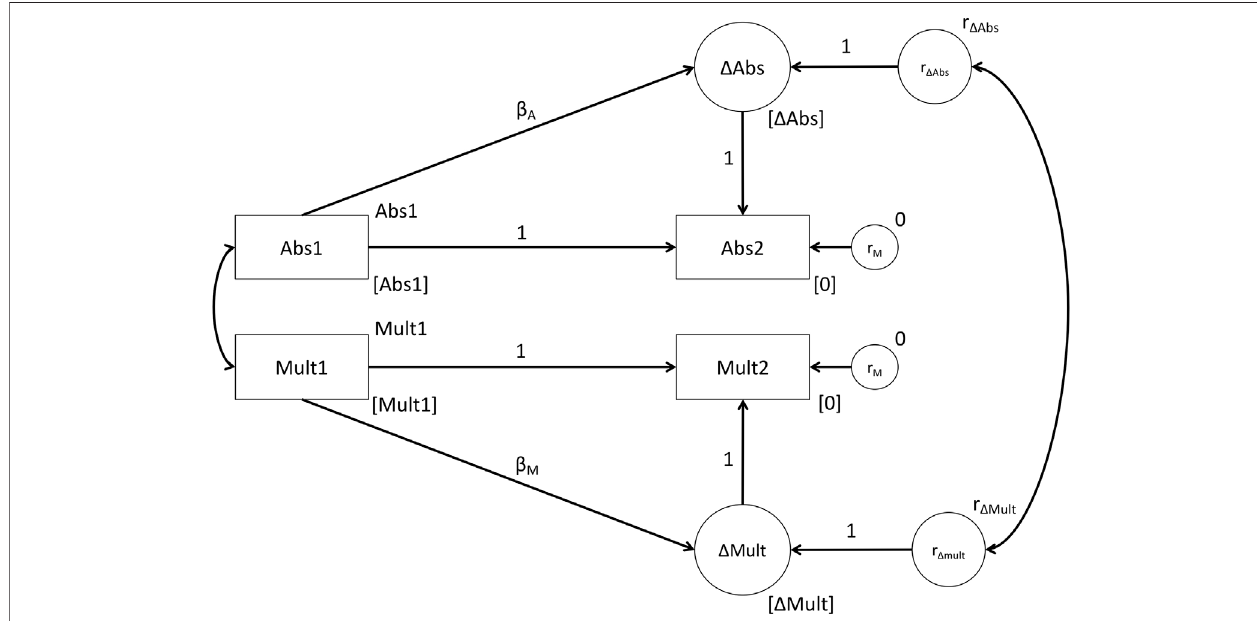
FIGURE 4 | Latent change regression score model for the EBI. Abs1 and Mult1 denote the epistemological beliefs at pretest, whereas Abs2 and Mult2 denote the epistemologicalbeliefsatposttest.Variables ’ meansaredepictedasthevariables ’ nameinsquarebracketsonthelowerrightsideofthevariable ’ ssymbolandvariables ’ variances are depicted as the variables ’ name at the upper right side of the variables ’ symbol, means and variances that were restricted are depicted as number. Path coef fi cients for the residuals were omitted.